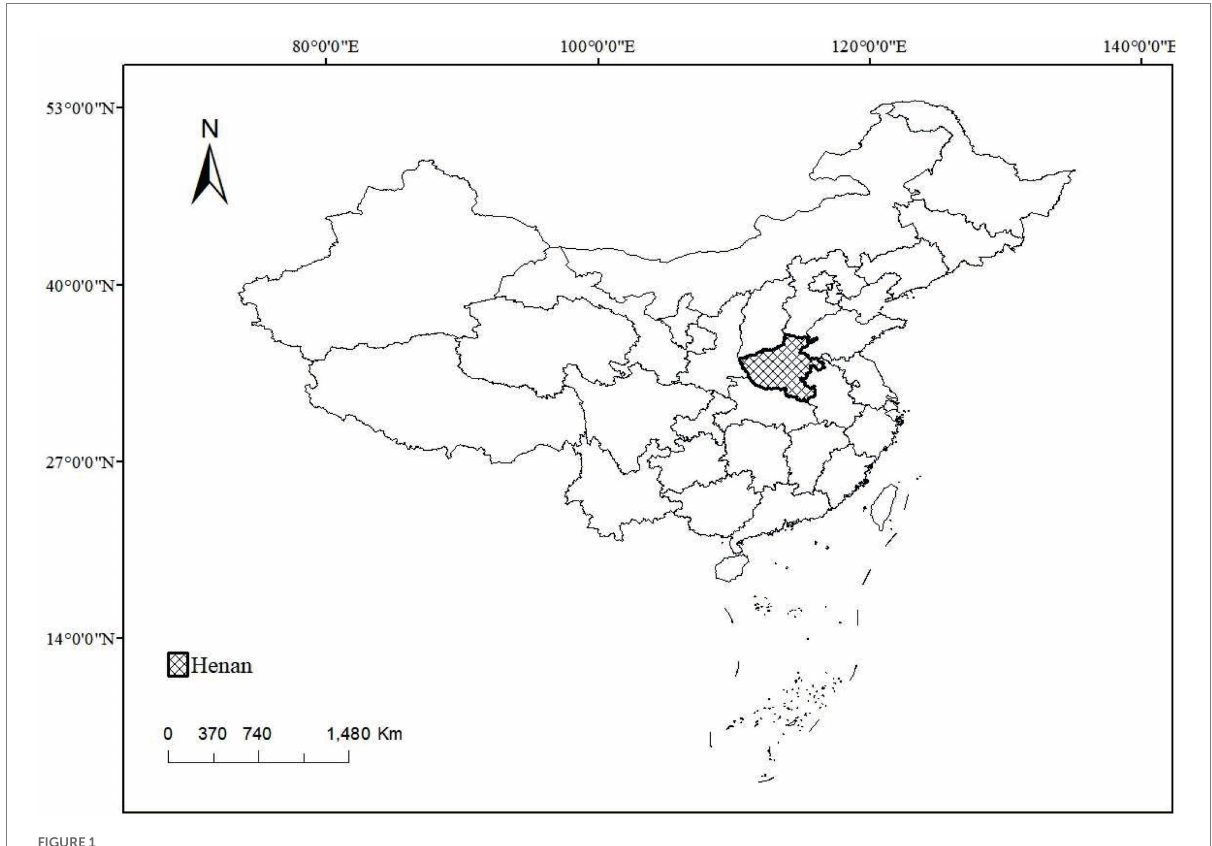
FIGURE 1 Geographical location of Henan Province on the map of